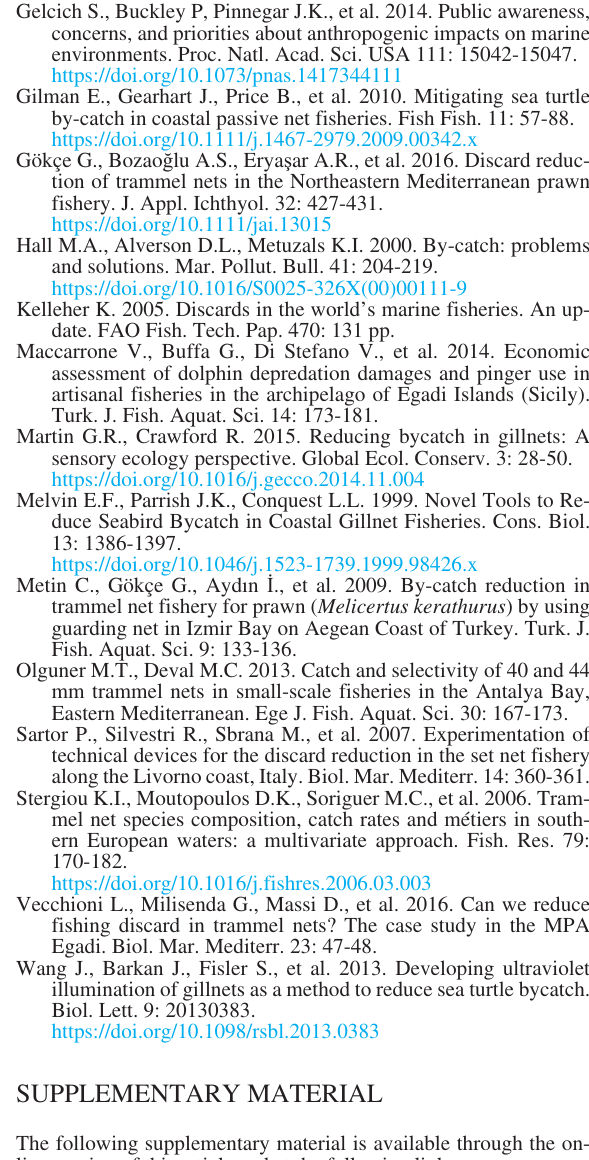
Table S1. – Two-way PERMANOVA table with factors net type (Ne) and depth (De), net type (Ne) and season (Se), and net type and target catch (Ta) for abundance of combined catch (includes commercial, commercial discard and by-catch). Table S2. – SIMPER analysis for the discards (commercial discards and by-catch) data for abundance with the factor season (au- tumn and winter). Table S3. – Simper analysis for the discards (commercial discards and by-catch) data for biomass with the factor season (autumn and winter). Table S4. – Simper analysis for the discards (commercial discards and by-catch) data for abundance with the factor target catch (sole season and cuttlefish season). Table S5. – Simper analysis for the discards (commercial discards and by-catch) data for biomass with the factor target catch (sole season and cuttlefish season). Table S6. – Simper analysis for the combined catch (commercial catch, commercial discards, and by-catch) data for abundance with the factor depth (10-20 m and 20-30 m). Table S7. – Simper analysis for the combined catch (commercial catch, commercial discards and by-catch) data for biomass with the factor depth (10-20 m and 20-30